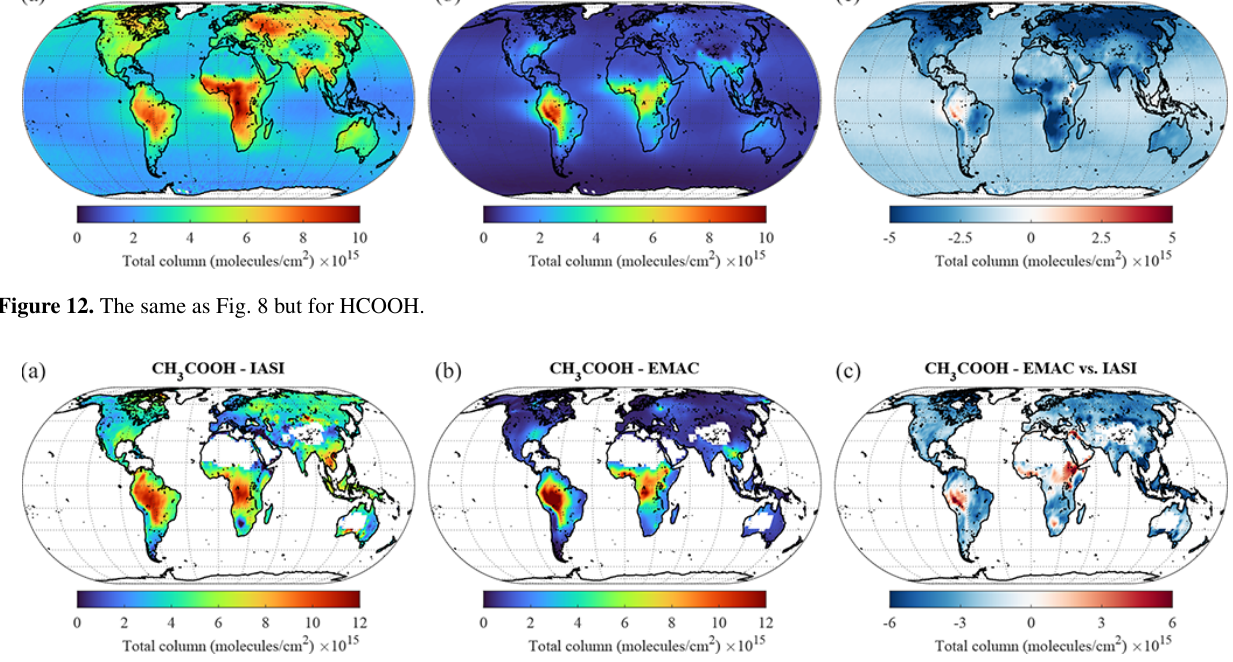
Figure 13. The same as Fig. 8 but for CH 3 COOH. Note that areas above ocean have been